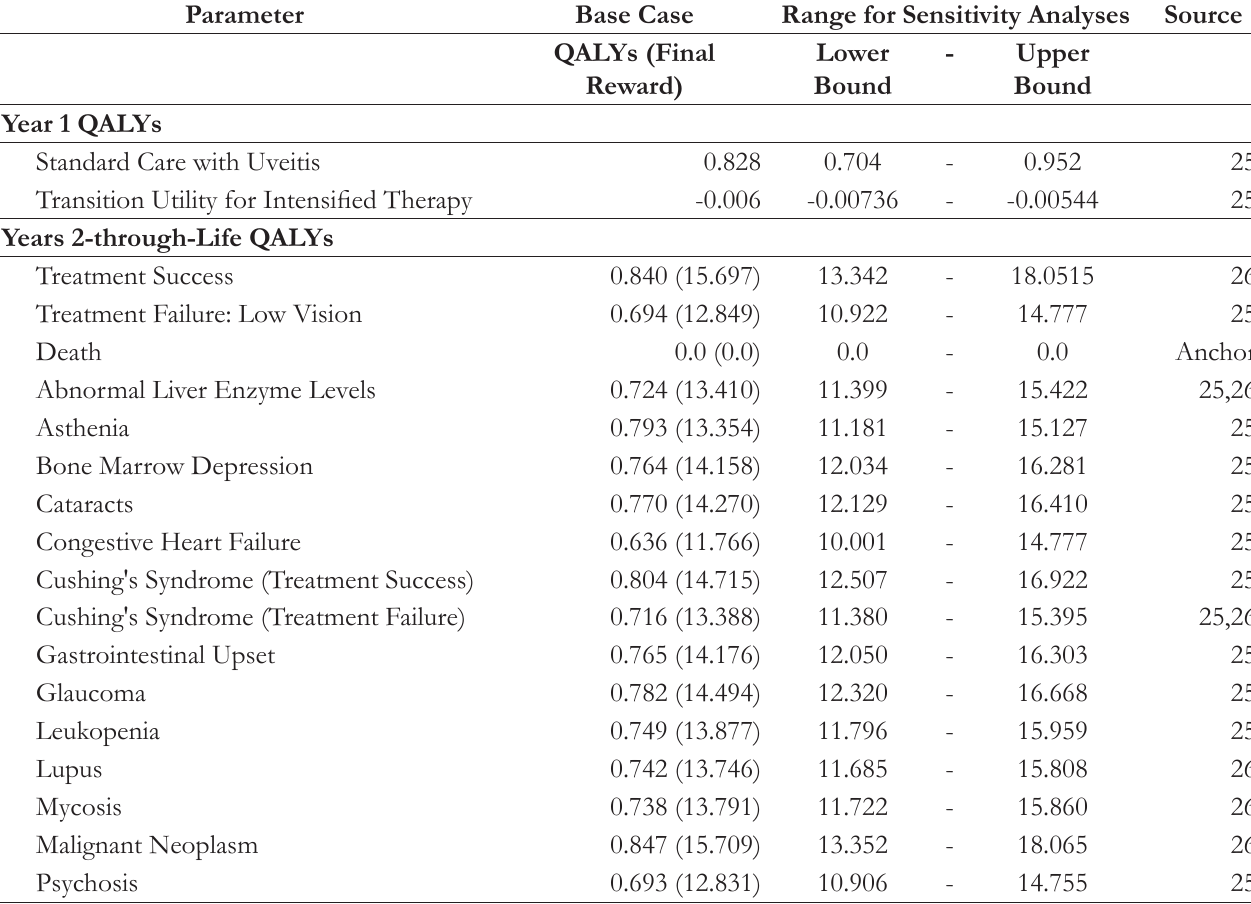
Table 1c. Health Utilities and Final